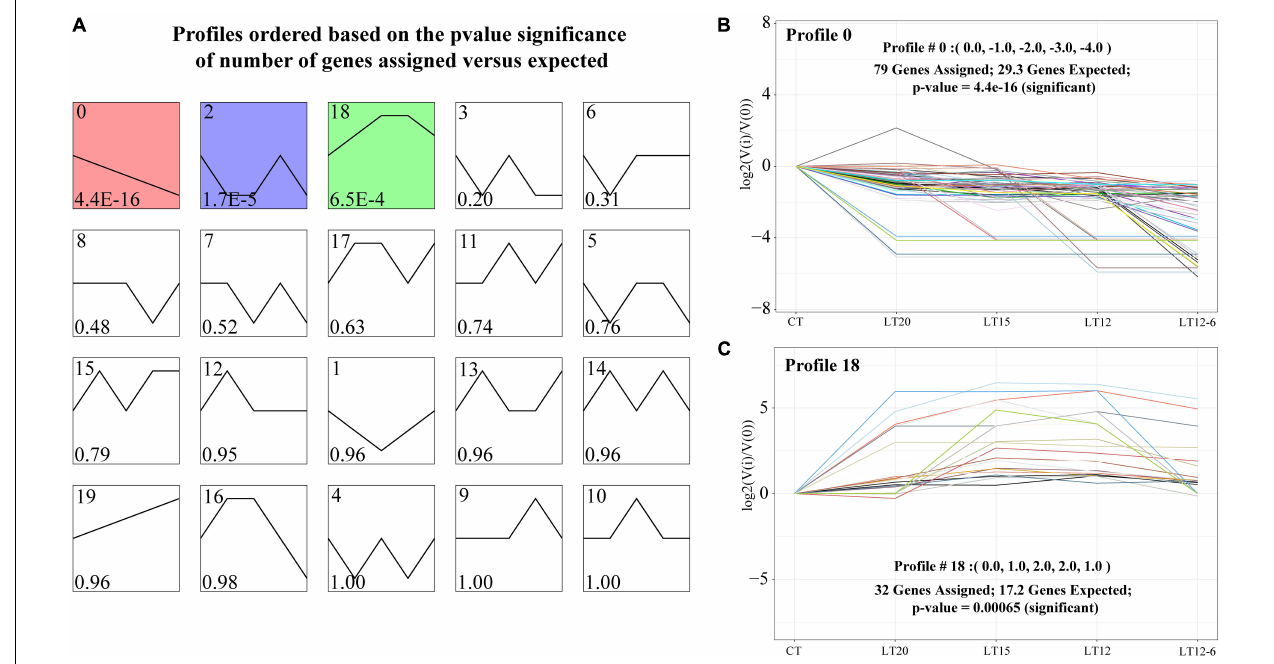
FIGURE 6 | STEM analysis and corresponding miRNA expression profiles. (A) Expression profiles of consistently up- or down-regulated miRNAs were screened ( P < 0.05). (B) Profile 0: miRNAs were uniformly down-regulated in all groups. (C) Profile 18: miRNAs were uniformly up-regulated in all groups.